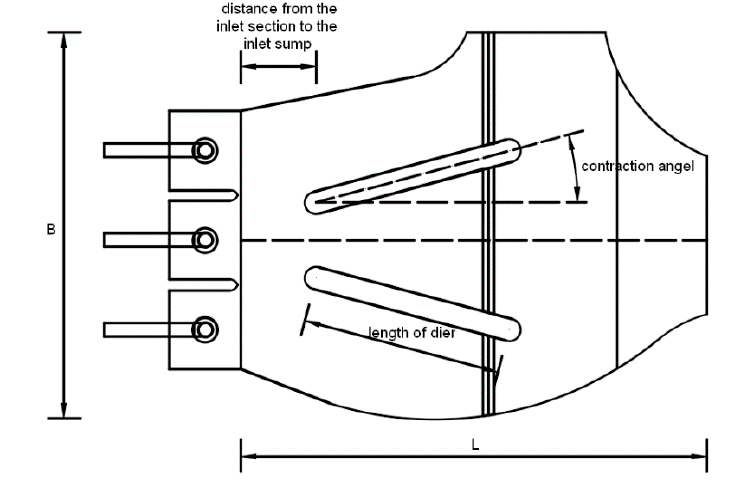
Figure 9. Geometric parameters contraction diversion pier.